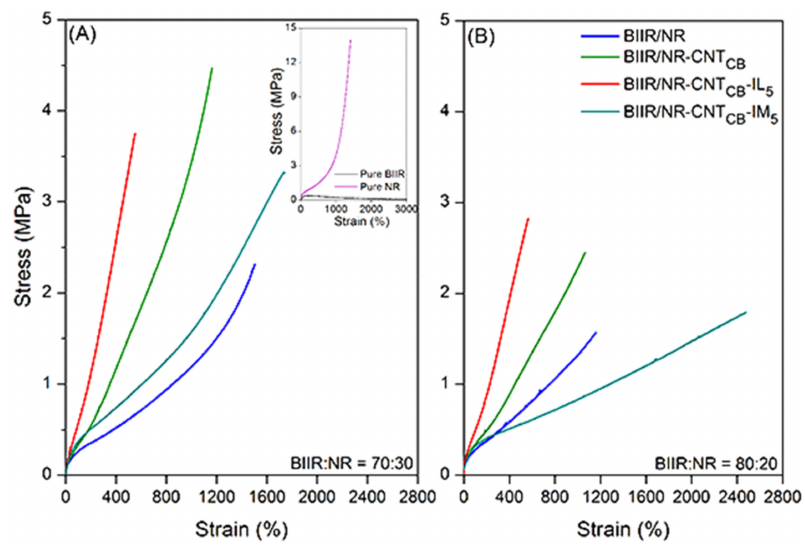
Figure 4. Stress–strain curves of pure rubbers and their composites with and without IL and IM modifiers, BIIR:NR ratios of 70:30 ( A ) and 80:20 ( B ) before healing propagation. Table 3. Mechanical properties in terms of 100%moduli, tensile strength and elongation at break of the pure rubbers and their composites before self-healing